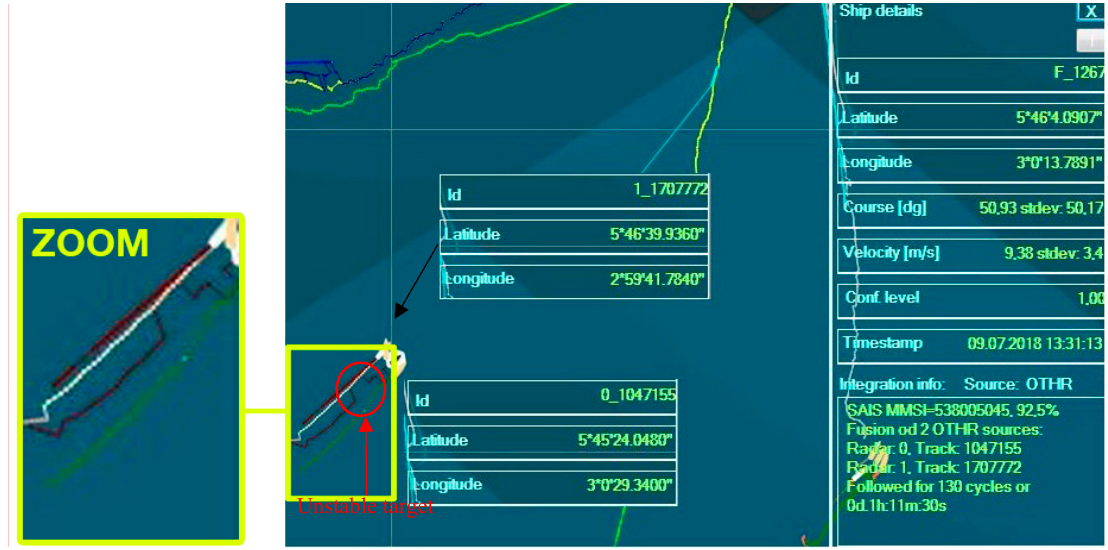
Figure 5. Update” (red trace: long radar track provided by radar 1, orange trace: fused track, yellow trace: new radar track provided by radar 0).